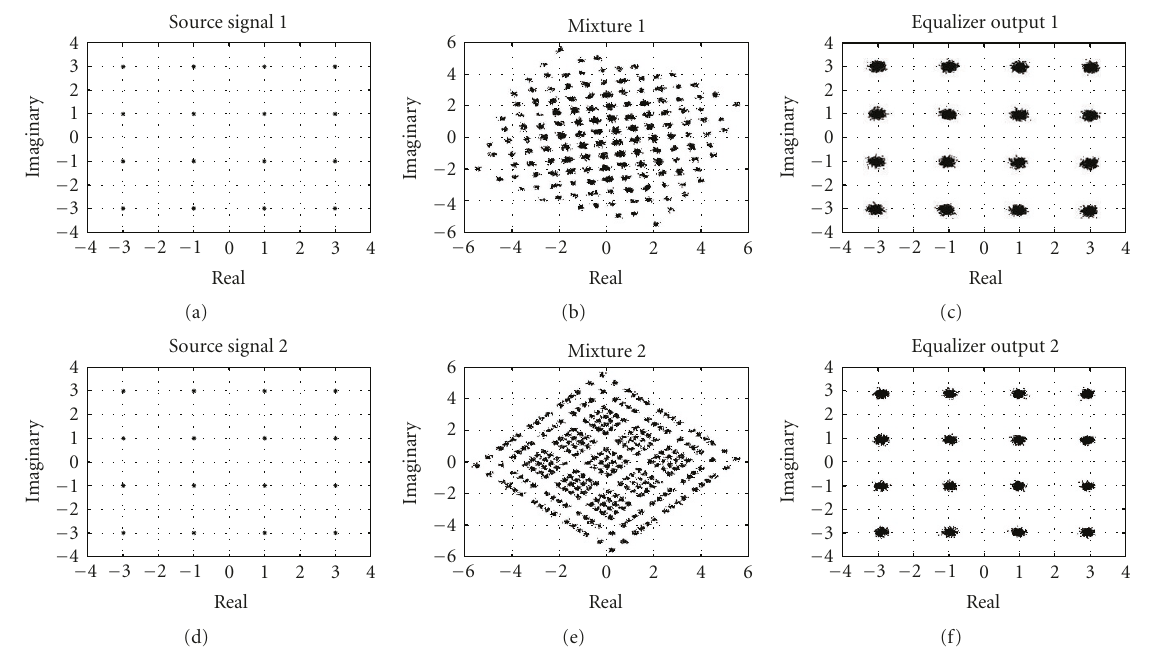
Figure 1: 16-QAM constellation. Left column: the constellations of the transmitted signals, middle column: the constellations of the received signals (mixtures), right column: the constellations of the recovered